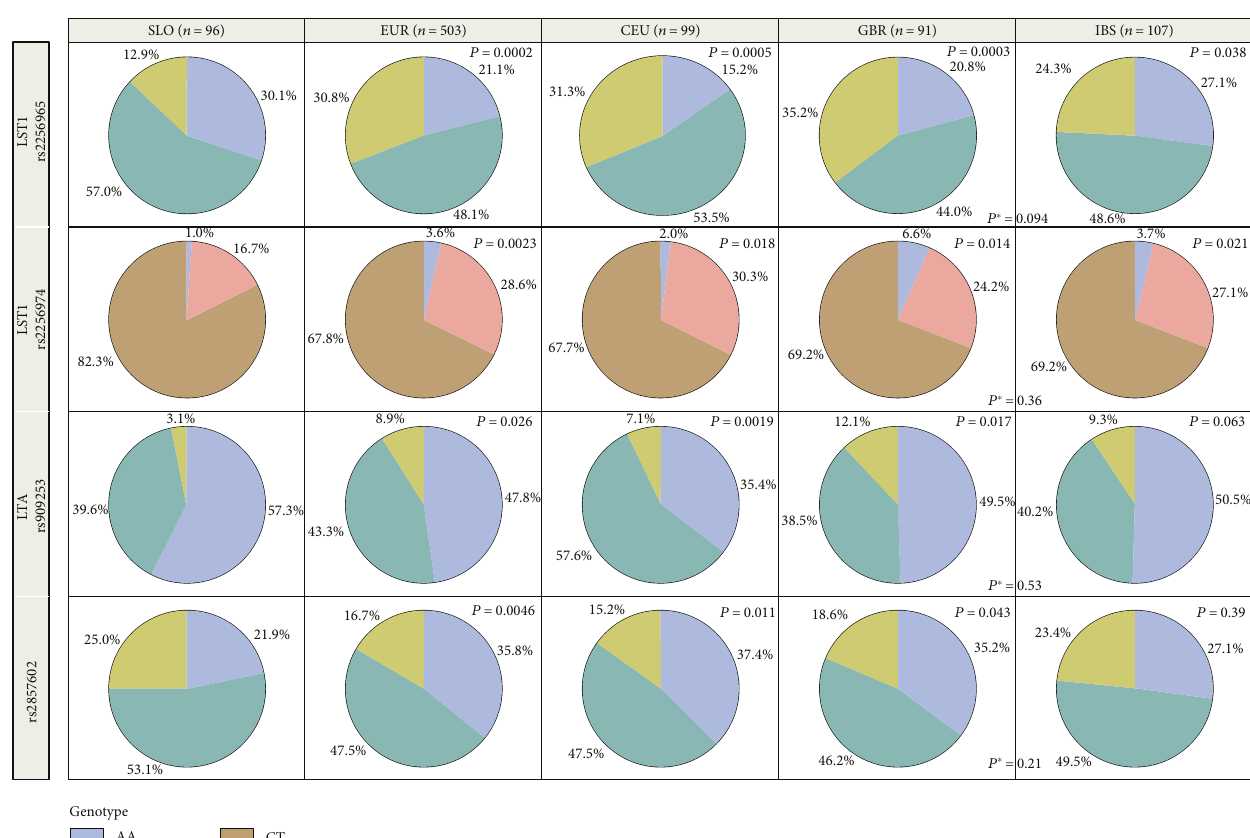
Figure 2: The genotype frequencies for 4 SNPs across European subpopulations. P value means di ff erence in genotype distribution between Slovenian population (SLO) and other populations (EUR, CEU, GBR and IBS). P ∗ value means di ff erence in genotype distribution between Great Britain population (GBR) and Iberian population (IBS)